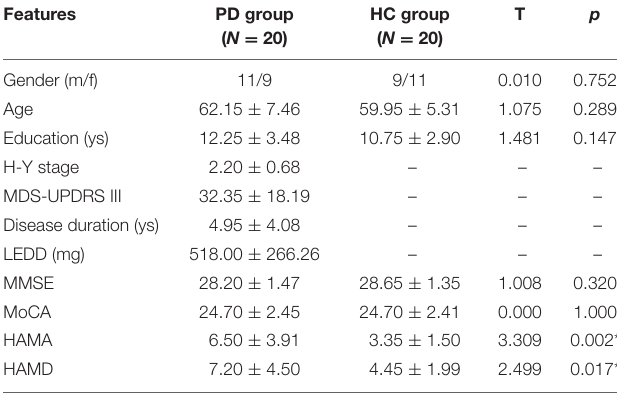
TABLE 1 | Demographics and clinical features of